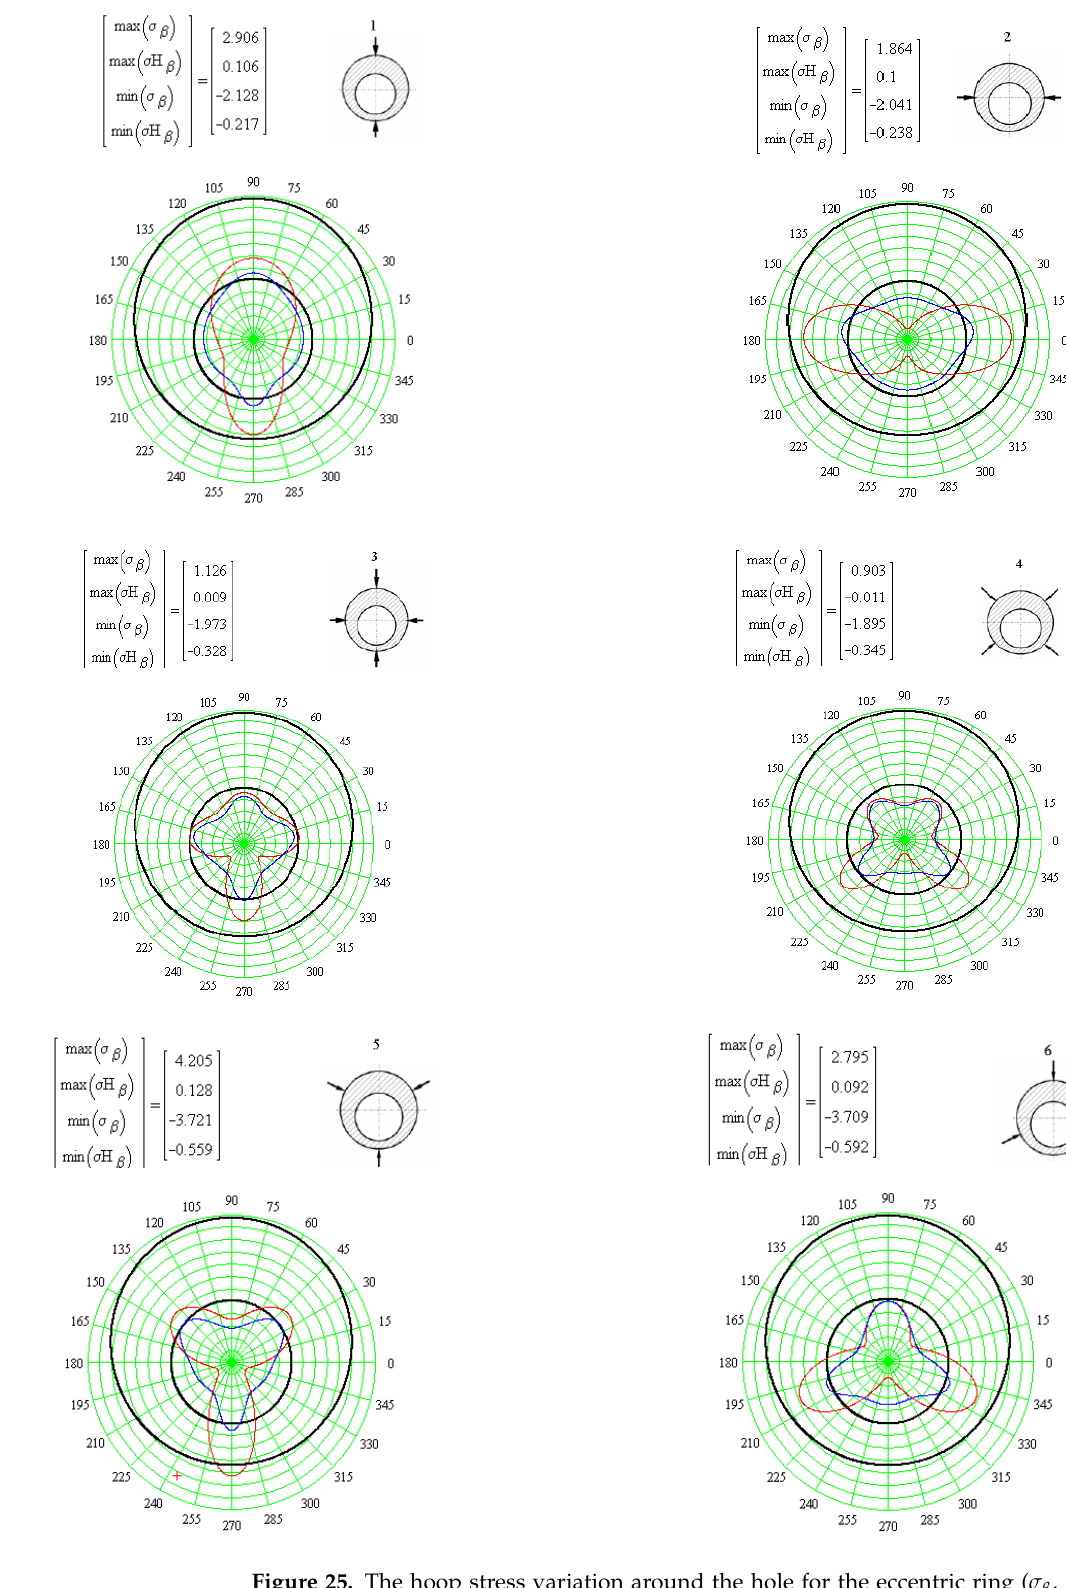
Figure 25. The hoop stress variation around the hole for the eccentric ring ( σ β , red) and for the compact disk ( σ H β , blue) and their extreme values for the six cases of